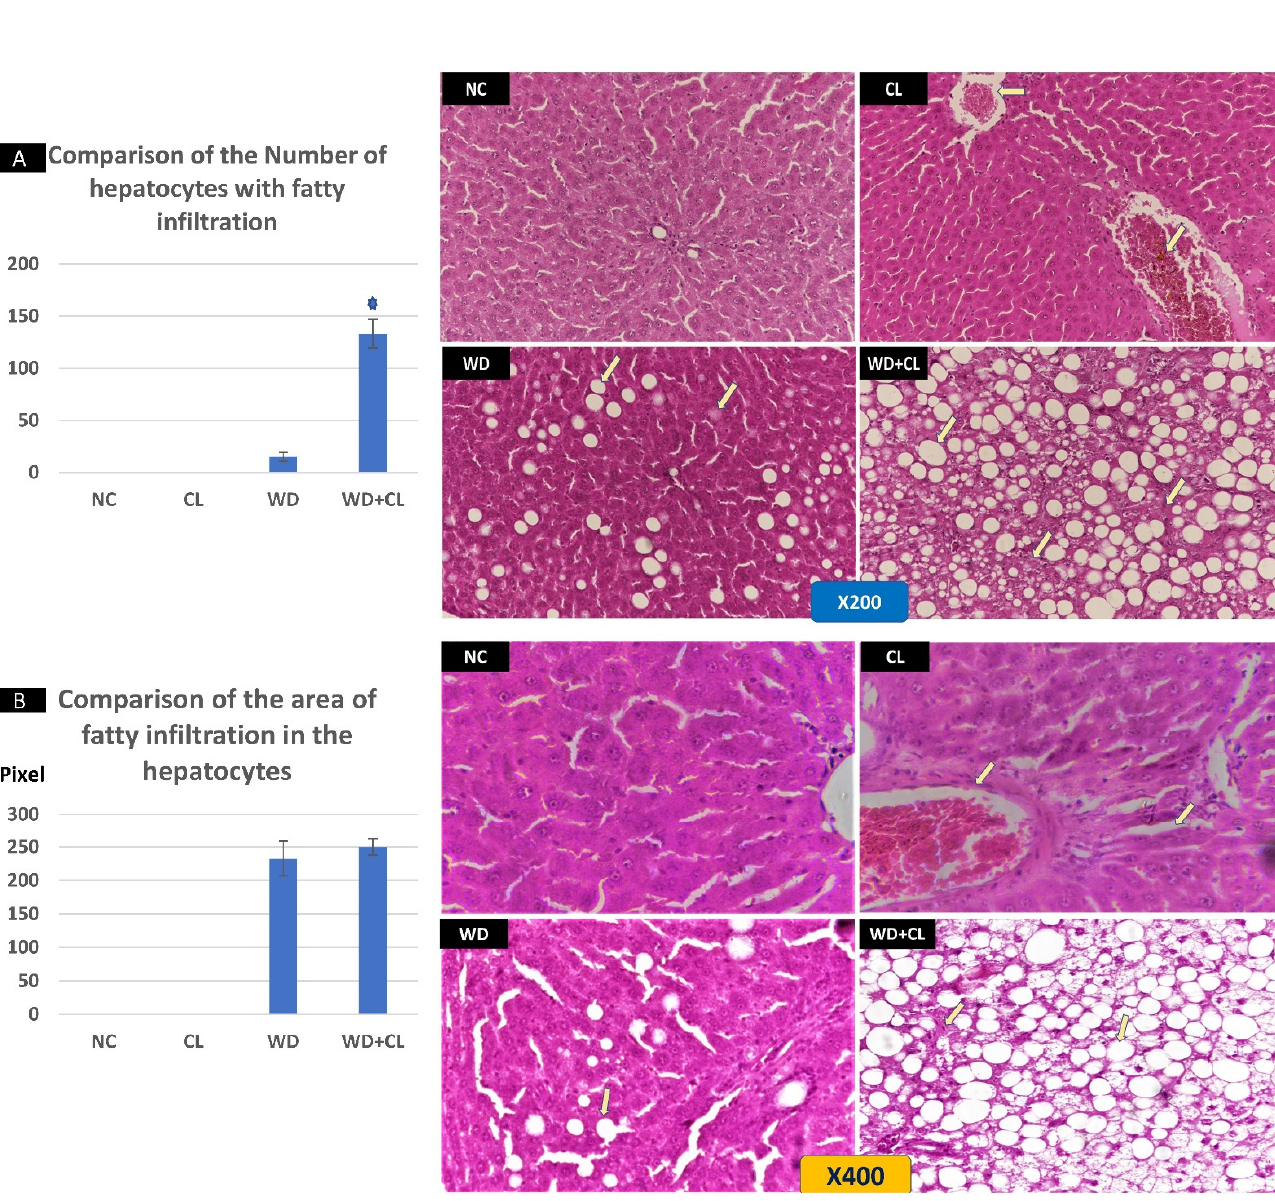
Figure 3. Histopathological changes in the liver tissue in different study groups at ×200 (above) and ×400 (below). The normal control (NC) slide shows normal hepatic tissue. Continuous light (CL) shows some congested hemorrhagic areas of different sizes and shapes (arrows) surrounded by degenerated hepatocytes, while the remaining tissue is normal. Western diet (WD) sections show the early fatty degeneration of hepatocytes with the intracellular deposition of fat droplets (both micro- and macro-vesicular steatosis) (arrows). Combined WD + CL shows that advanced fatty degeneration was noticed in the liver parenchyma with few remnants of compressed hepatocytes (arrows). The number of hepatocytes with macro-vesicular steatosis is significantly higher in the WD + CL ( A ). However, the size of hepatocytes with macro-vesicular steatosis is relatively similar in both WD and WD + CL ( B ). * p < 0.05.